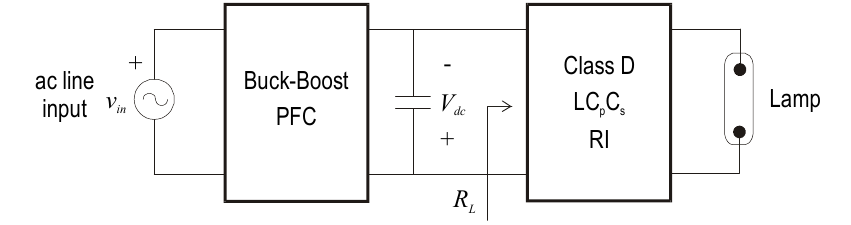
Figure 3. Two-stage electronic ballast structure.